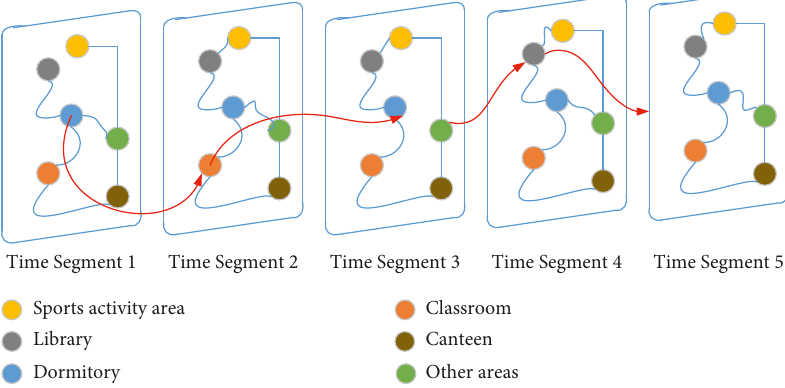
Figure 1: Diagram of spatial and temporal correlation of campus daily behavior